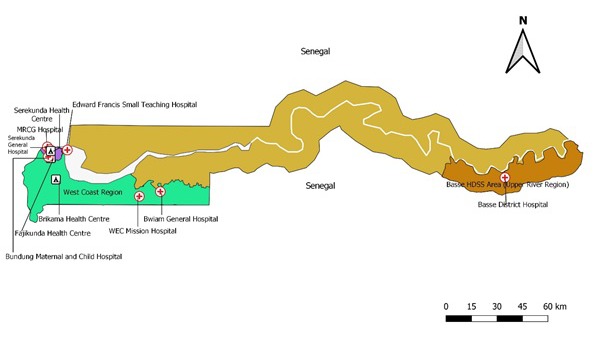
Map of Gambia showing the study sites, including the health facilities involved in Haemophilus influenzae type b (Hib) disease surveillance and Hib carriage studies.